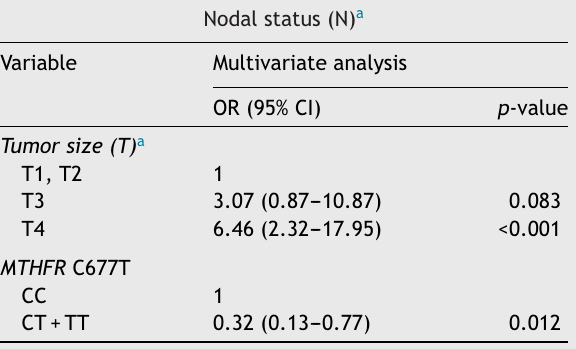
Multivariate analysis of the nodal status,